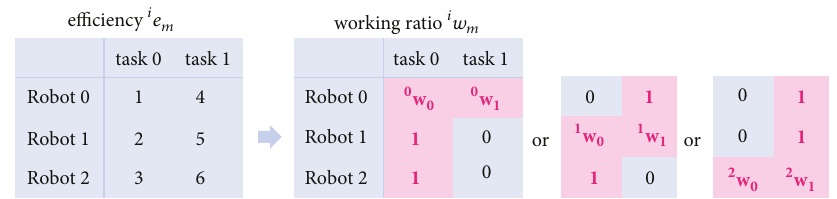
Figure 5: Comparative advantage with two tasks and multiple agents.